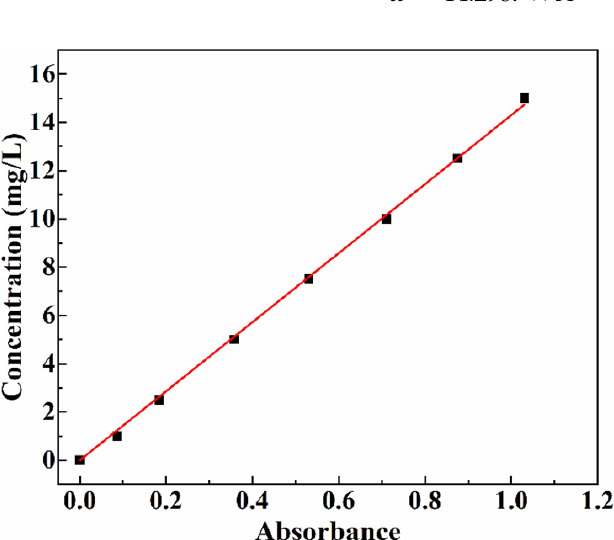
Figure 1. Relationship between MB concentration and absorbance.